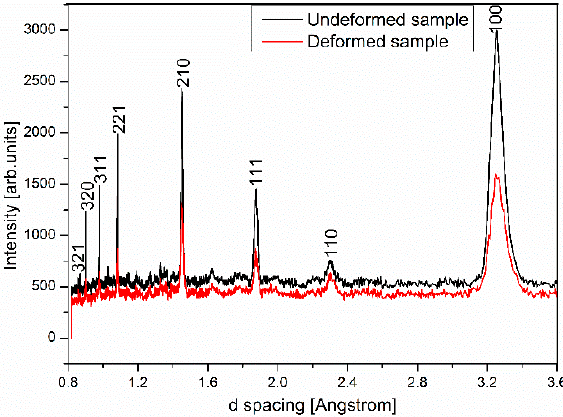
Figure 5. Effects of plastic deformation on NPD patterns (measured with KOWARI